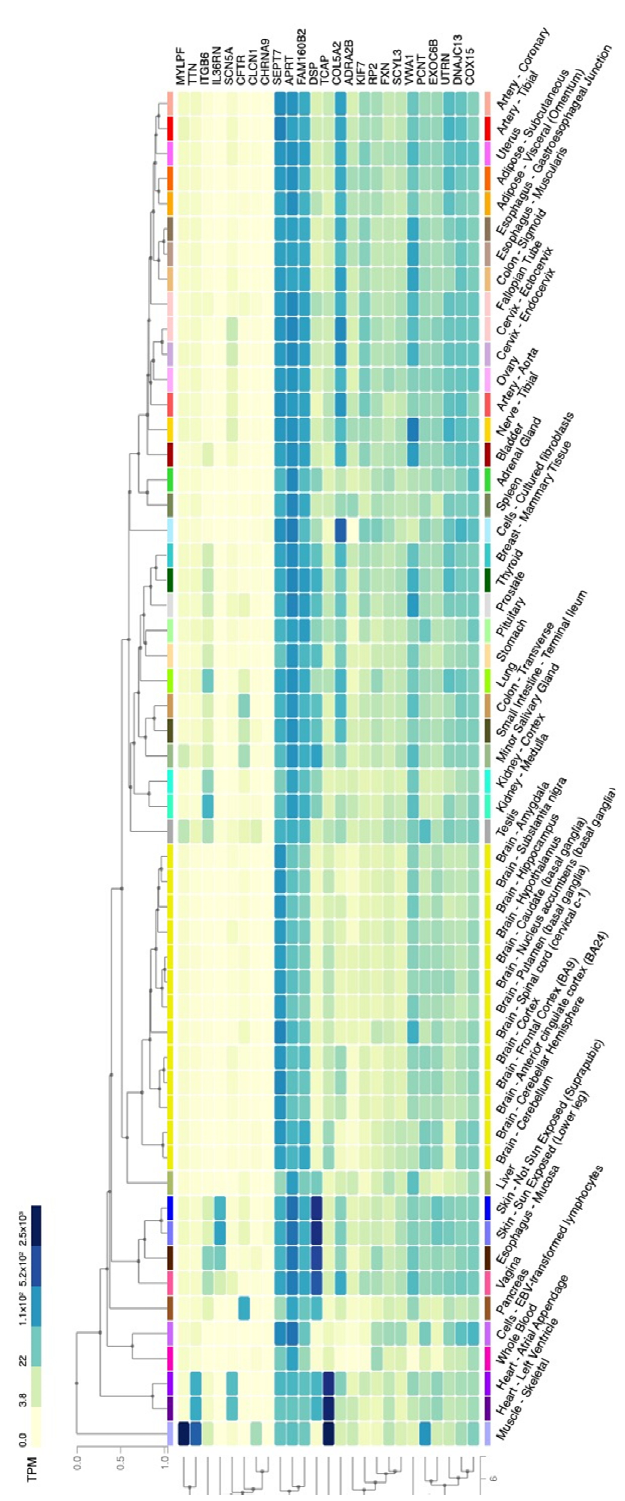
Figure 4. Tissue expression of candidate genes identified in patient 7. The value of gene expression was shown as TPM (Transcript Per Million) and colored according to the color scale at the top left. Each column represents a tissue type. Each row represents the expression level of a certain gene.